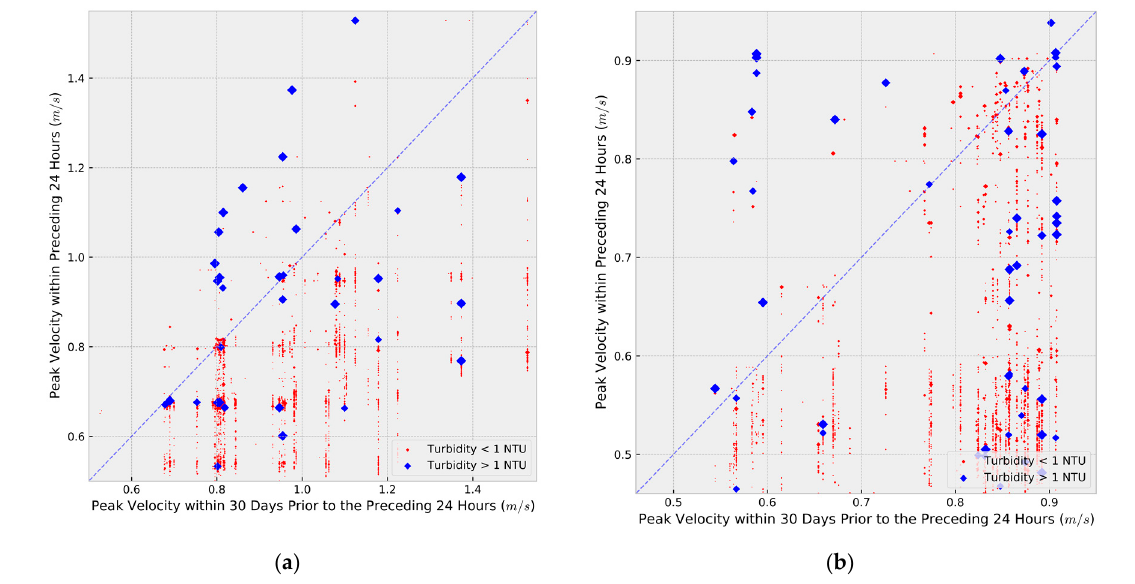
Figure 4. For each turbidity observation, the 24-h preceding peak velocity was plotted against the peak velocity of the 30 days prior to the 24 h preceding the turbidity observation. ( a ) Site 2, Turbidity Meter C, Pipe H; ( b ) Site 3, Turbidity Meter D, Pipe K.